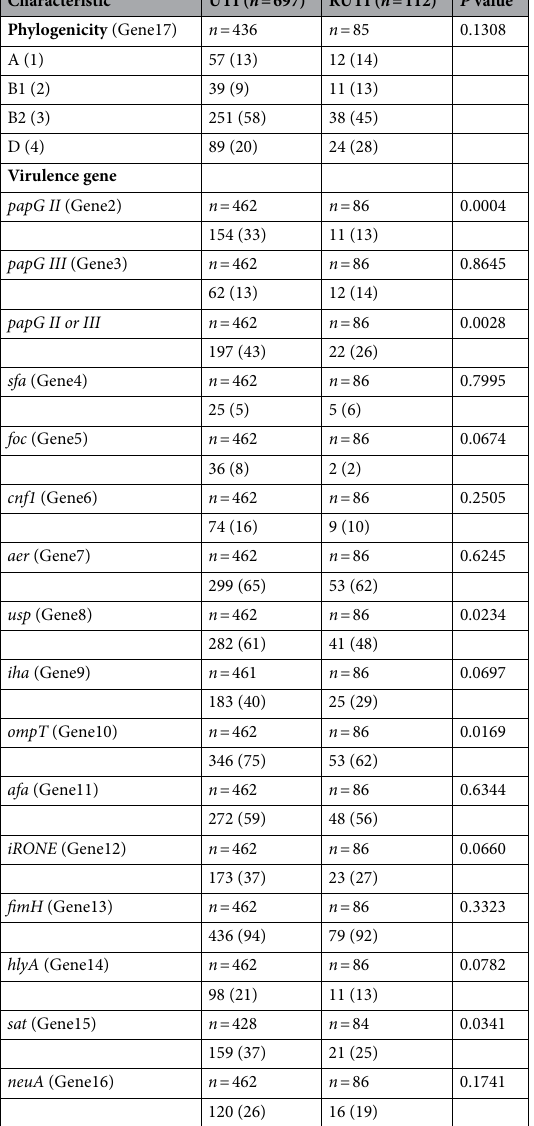
Data are presented with number (percentage). Abbreviations: UTI, urinary tract infection; RUTI, recurrent urinary tract